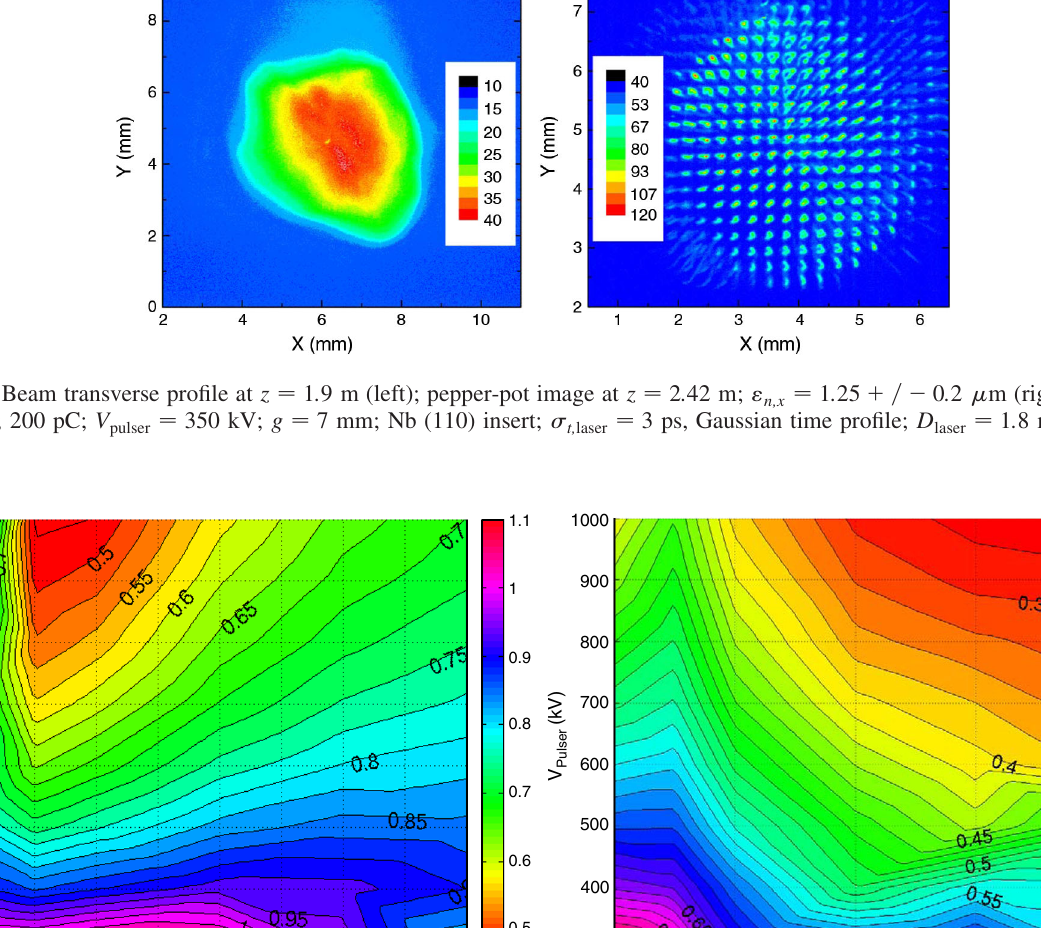
is the voltage applied across pulser ¼ 1 : 08 mm ; rise = fall time ¼ 0 : 7 ps ; 11.3 ps full laser